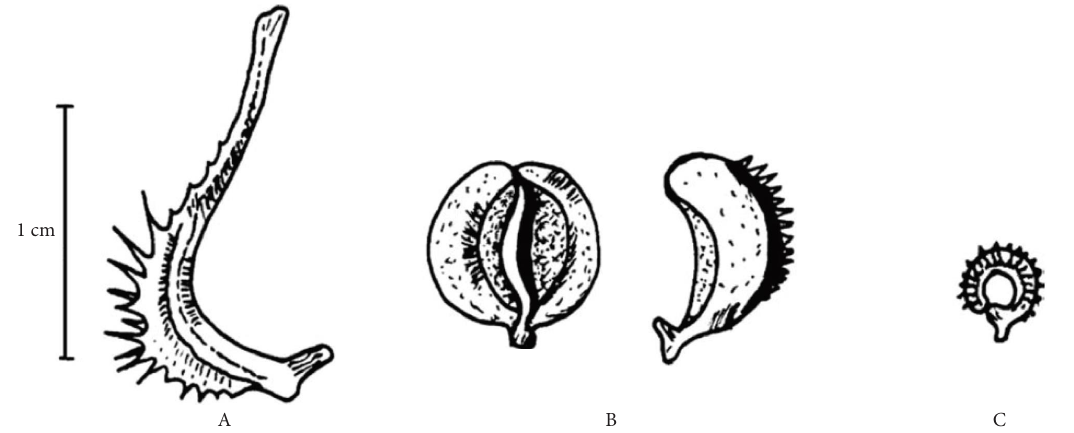
Figure 2: Morphology of C. arvensis achenes: (a) rostrate; (b) cymbiform; (c)